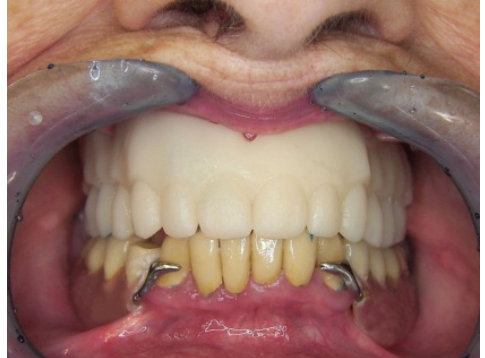
Figure 16. The midline has to move slightly to the right, regardless of the midline below. Moreover a cervical movement of 21 to the distal and a slight movement of 22 and 23 downwards were recommended.